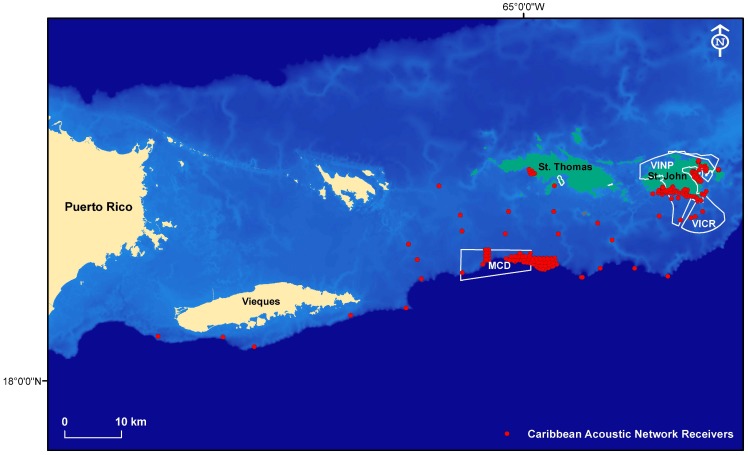
Location of underwater acoustic receivers in the U.S. Caribbean Acoustic Network (USCAN) on the southern insular shelf of Puerto Rico and U.S.Virgin Islands. MPA boundaries are shown for the Virgin Islands National Park (VINP), Virgin Islands Coral Reef Monument (VICR) and the Marine Conservation District (MCD).